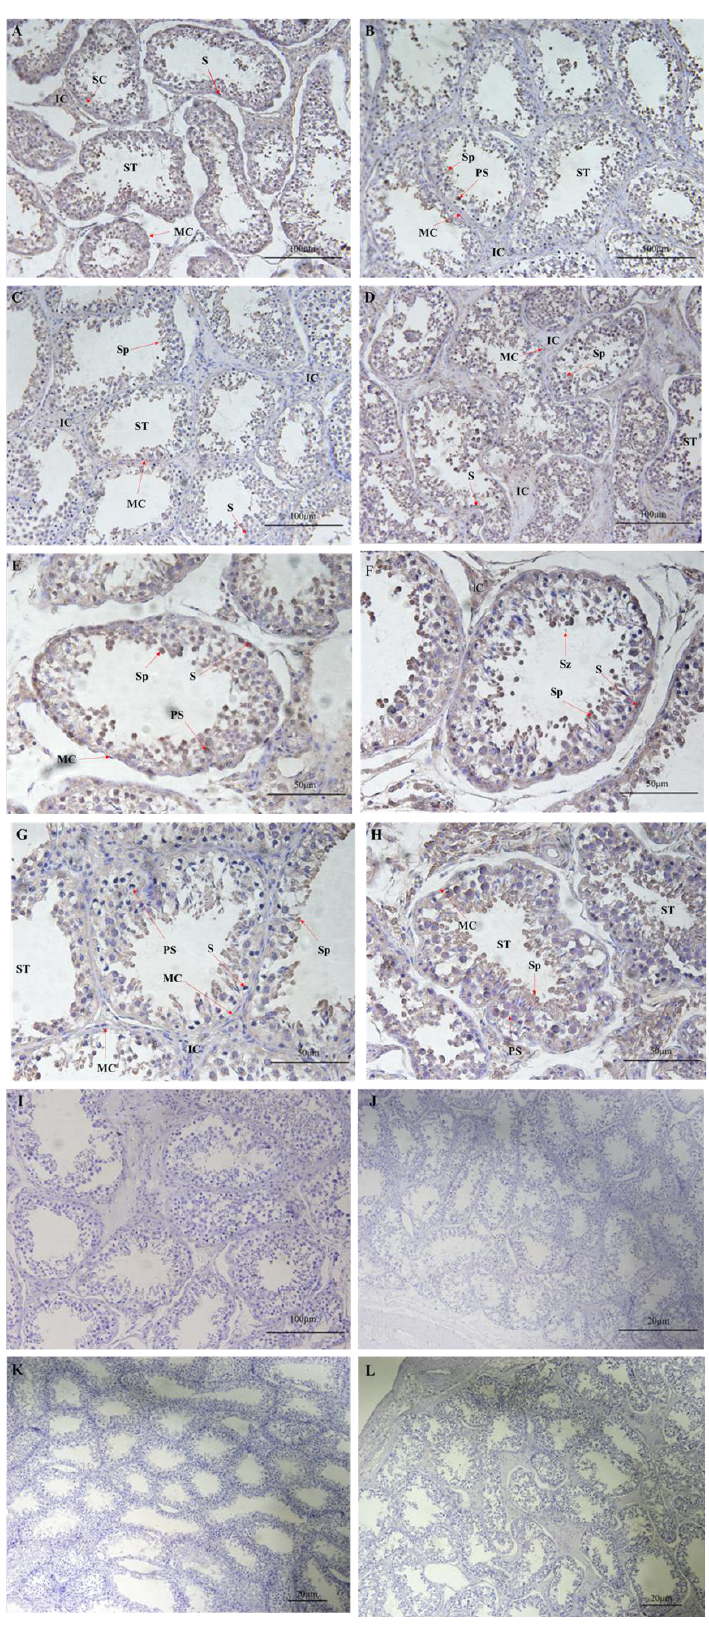
Figure 4. Localization of FAF1 protein expression in testes of different ages. (A–L) Immunohistochem- ical staining. ( A – H ) Positive expression of FAF1. ( I – L ) Negative control of FAF1. ( A , F , I ) One-year-old B. grunniens testis. ( B , F , G ) Four-year-old B. grunniens testis. ( C , G , K ) Seven-year-old B. grunniens